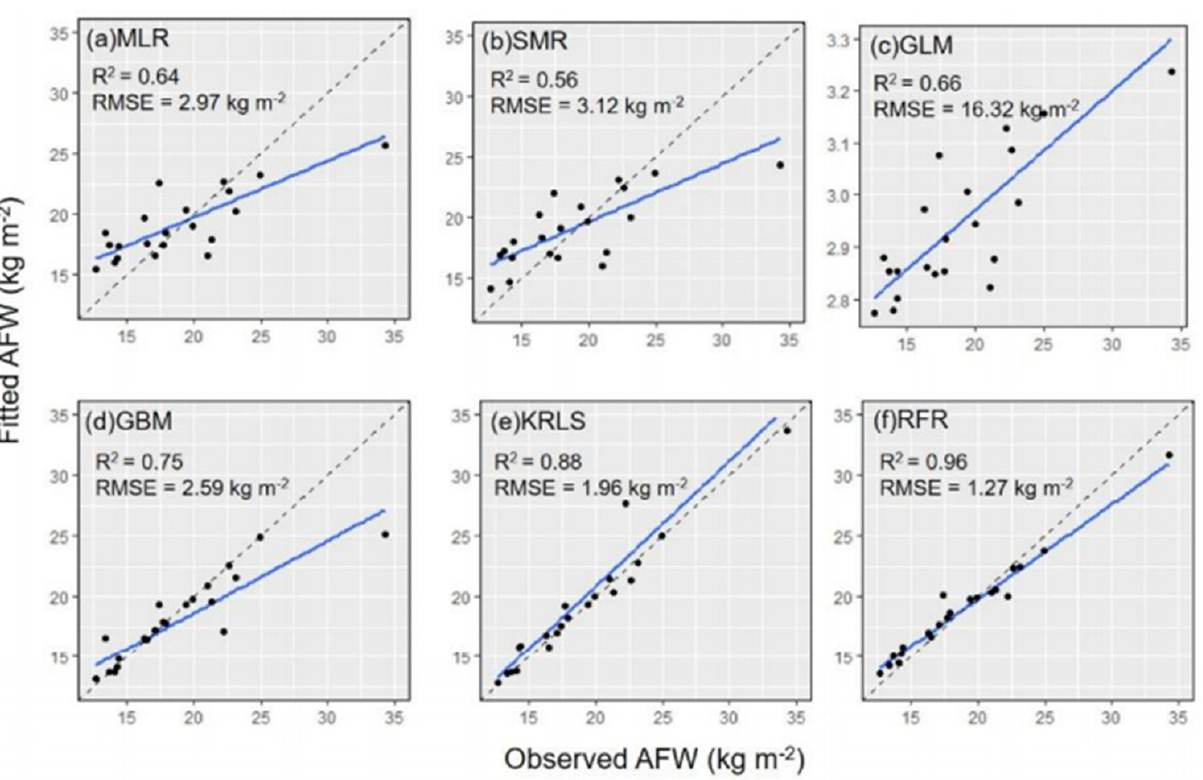
Figure 6. Relationship between observed aboveground fresh weight (AFW) and fitted AFW of sugarcane via different analytical methods. Reprint form Ref. [44]. Table 5. Comparison of LiDAR data in weed, crop and soil detection and crop growth estimation. LiDAR